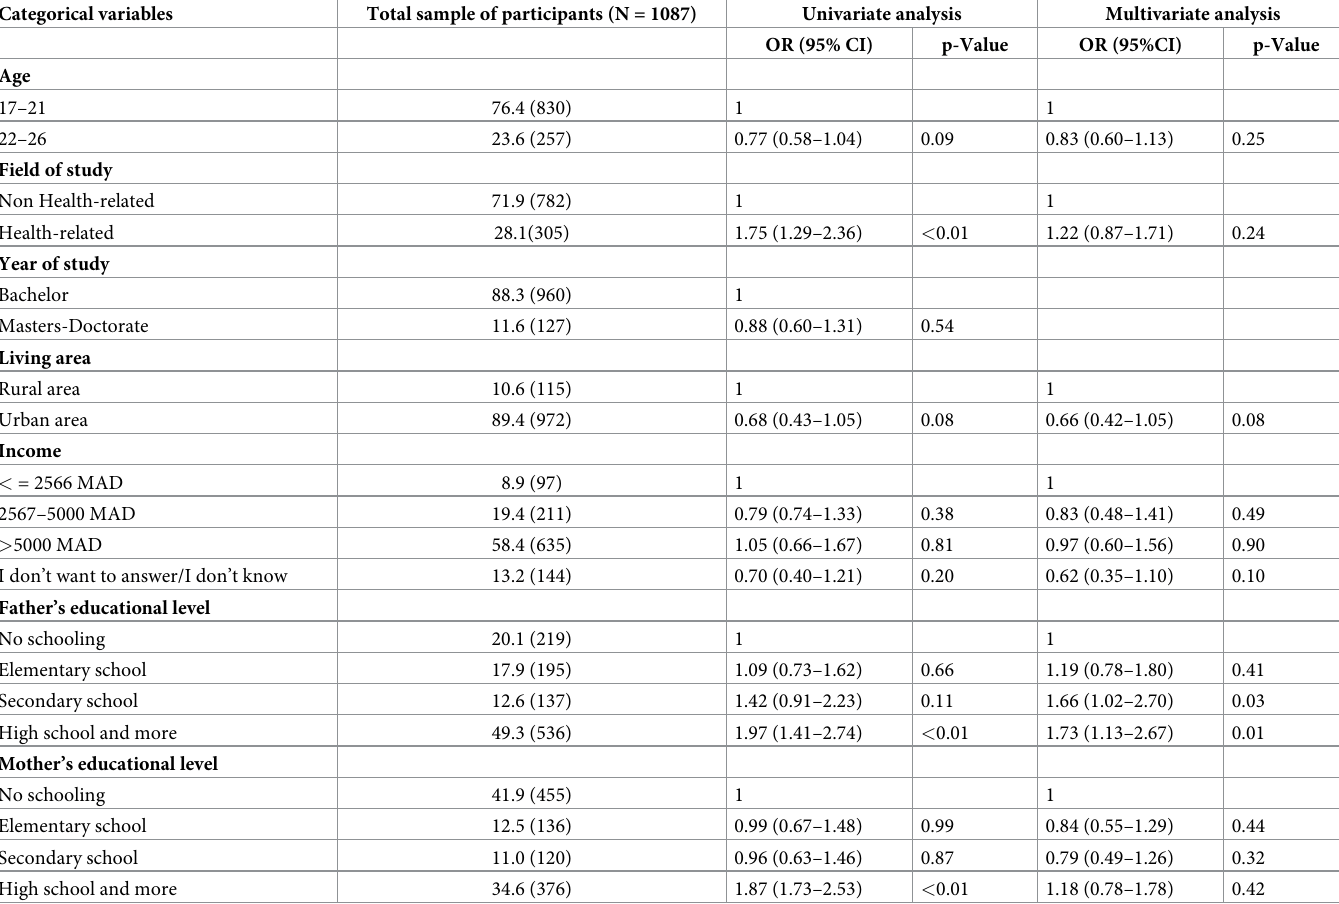
Table 1. Socio-demographic characteristics of participants by HPV vaccine acceptability. Morocco between May 2019 and June 2020 (N = 1087 )